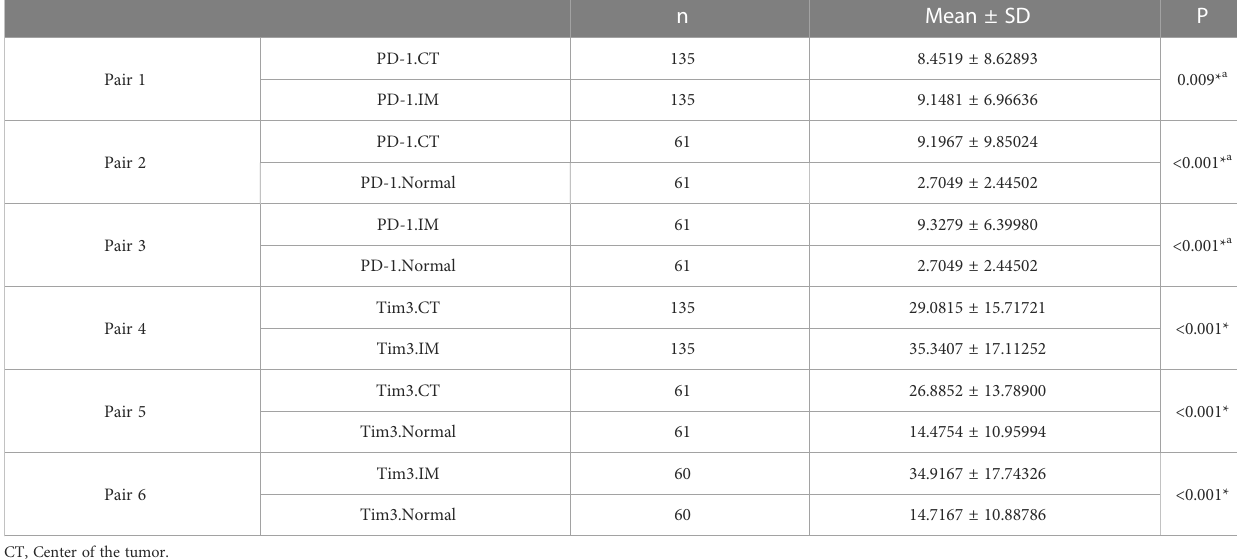
TABLE 4 The mean expression of PD-1 and Tim3 in the center of the tumor, invasive margin, and normal-like tissue and their